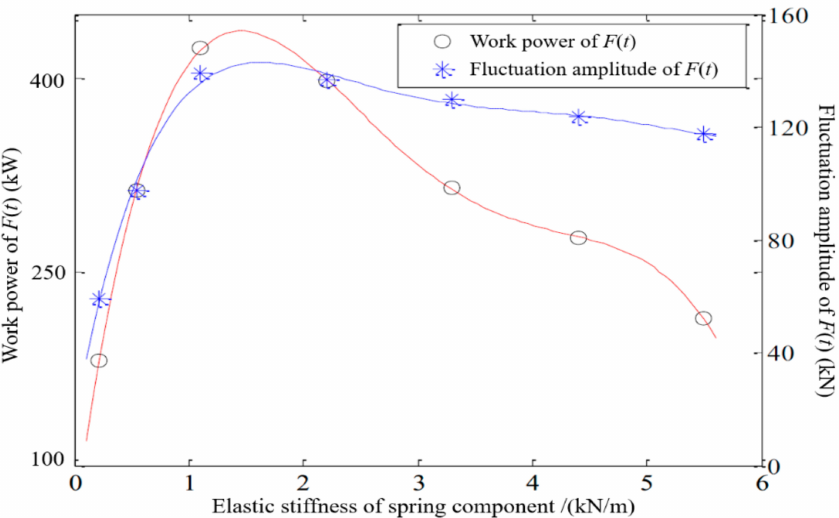
Figure 18. The variation of work power and fluctuation amplitude of F ( t ) with elastic stiffness. The fluctuation amplitude of F ( t ) increased sharply at fist and then decreased slowly with the increasing of elastic stiffness. When the elastic stiffness was 1 kN/mm, the F ( t ) var- ied from − 68 kN to 70 kN. At this time, the amplitude of F ( t ) was the largest, about 138 kN. The work power of F ( t ) to the spring component increased sharply at fist and then decreased with the increasing of elastic stiffness. When the elastic stiffness was between 1 kN/mm and 2 kN/mm, the equivalent excitation force had the largest working power for the spring component, above 400